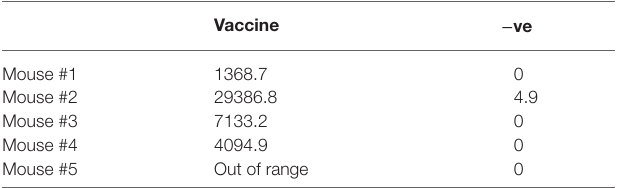
TABLE 1 | Summary of ID50 titers in mice immunized with the plant-produced S ∆ TM (vaccine) or immunized with PBS formulated with Alhydrogel ® adjuvant ( −